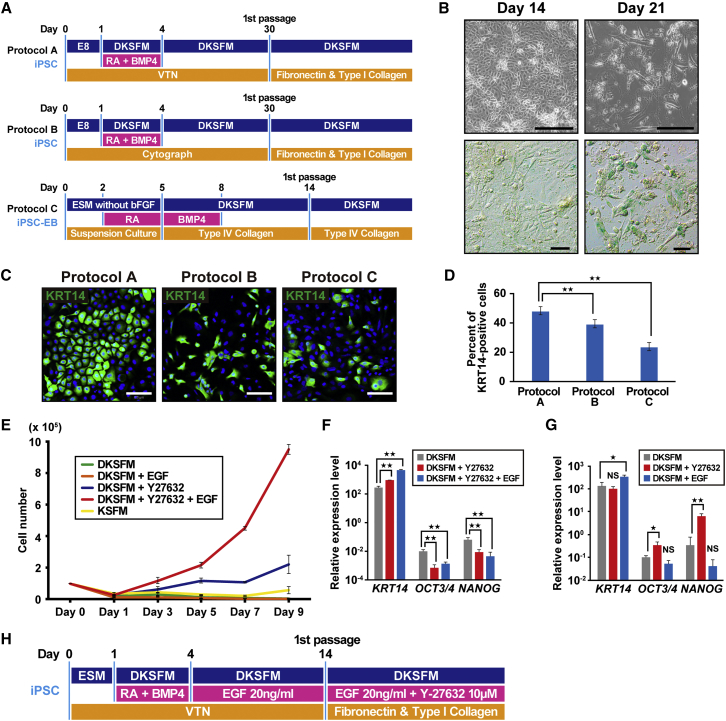
Establishment of Differentiation Protocol of iPSCs into the Lineage of Keratinocytes(A) Schematic of the three differentiation protocols for generation of keratinocytes from iPSCs. Protocols A and B differed in the coating agents. Protocol C was performed via embryoid body (EB) formation (iPSC-EB). DKSFM, defined keratinocyte serum-free medium; RA, retinoic acid; BMP4, bone morphogenetic protein 4; VTN, vitronectin; E8, Essential 8 medium; ESM, ESC medium.(B) β-Galactosidase staining of iPSC-KCs at the indicated time points (days 14 and 21). Cell senescence was observed at day 21 of the induction. Scale bars, 100 μm.(C) iPSC-derived keratinocytes with different methods (protocols A, B, and C) at passage 2 were immunocytochemically stained with anti- KRT14 antibody. Homogeneous keratinocyte-like cells were stained in protocol A. Scale bars, 100 μm.(D) The number of cells positive for KRT14. The number of KRT14-positive cells were highest in protocol A (48.08%), compared with protocol B (39.24%) and protocol C (23.62%). Data are shown as mean ± SD of the cell number from three independent experiments. KRT14, keratin 14. ∗∗p < 0.01.(E) The growth rate of iPSC-derived keratinocytes with different treatment. A combination of Y-27632- and EGF accelerated cell growth. EGF, epidermal growth factor; DKSFM, defined keratinocyte serum-free medium; KSFM, keratinocyte serum-free medium.(F) Real-time qPCR analysis of KRT14 and stem cell markers, i.e., OCT3/4 and NANOG, in iPSC-KCs at passage 2. KRT14 expression increased by the addition of epidermal growth factor (EGF). Data shown are mean ± SD of the expressions from three independent experiments. ∗∗p < 0.01.(G) Real-time qPCR analysis of KRT14 and stem cell markers in iPSC-KCs at passage 0. Gene expression levels of OCT3/4 and NANOG increased in the presence of Y-27632, whereas the KRT14 expression level remained unchanged by the treatment of Y-27632. Data are presented as mean ± SD from three independent experiments. ∗p < 0.05, ∗∗p < 0.01. NS, not significant.(H) Schematic of the final protocol design for differentiation of iPSCs into keratinocytes. iPSC-KC, iPSC-derived keratinocytes; KSFM, keratinocyte serum-free medium; DKSFM, defined keratinocyte serum-free medium; RA, retinoic acid; BMP4, bone morphogenetic protein 4.See also Figure S2.